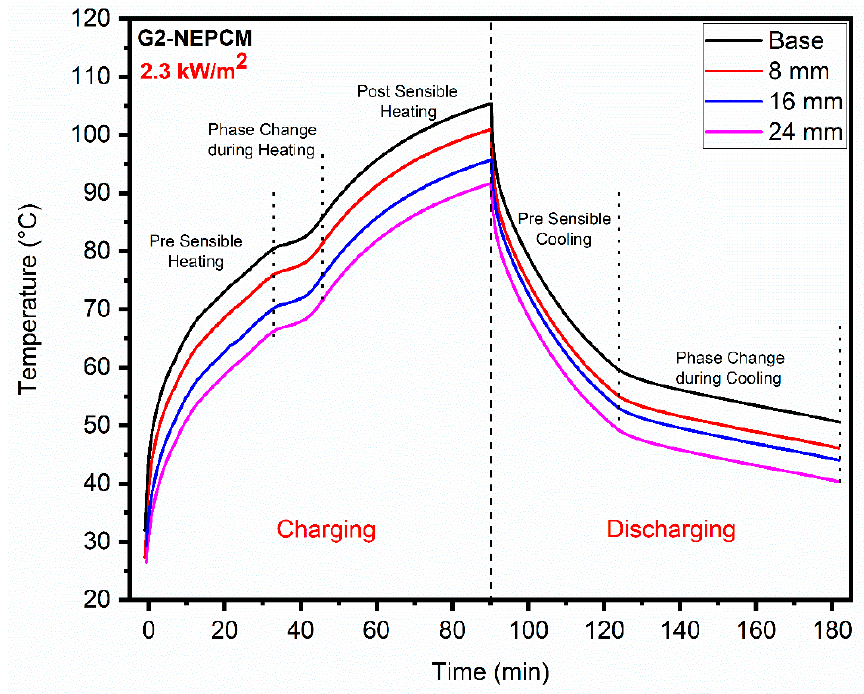
Figure 15. Spatial temperature distribution within heat sink filled with G2-NEPCM at 2.3 kW/m 2 .